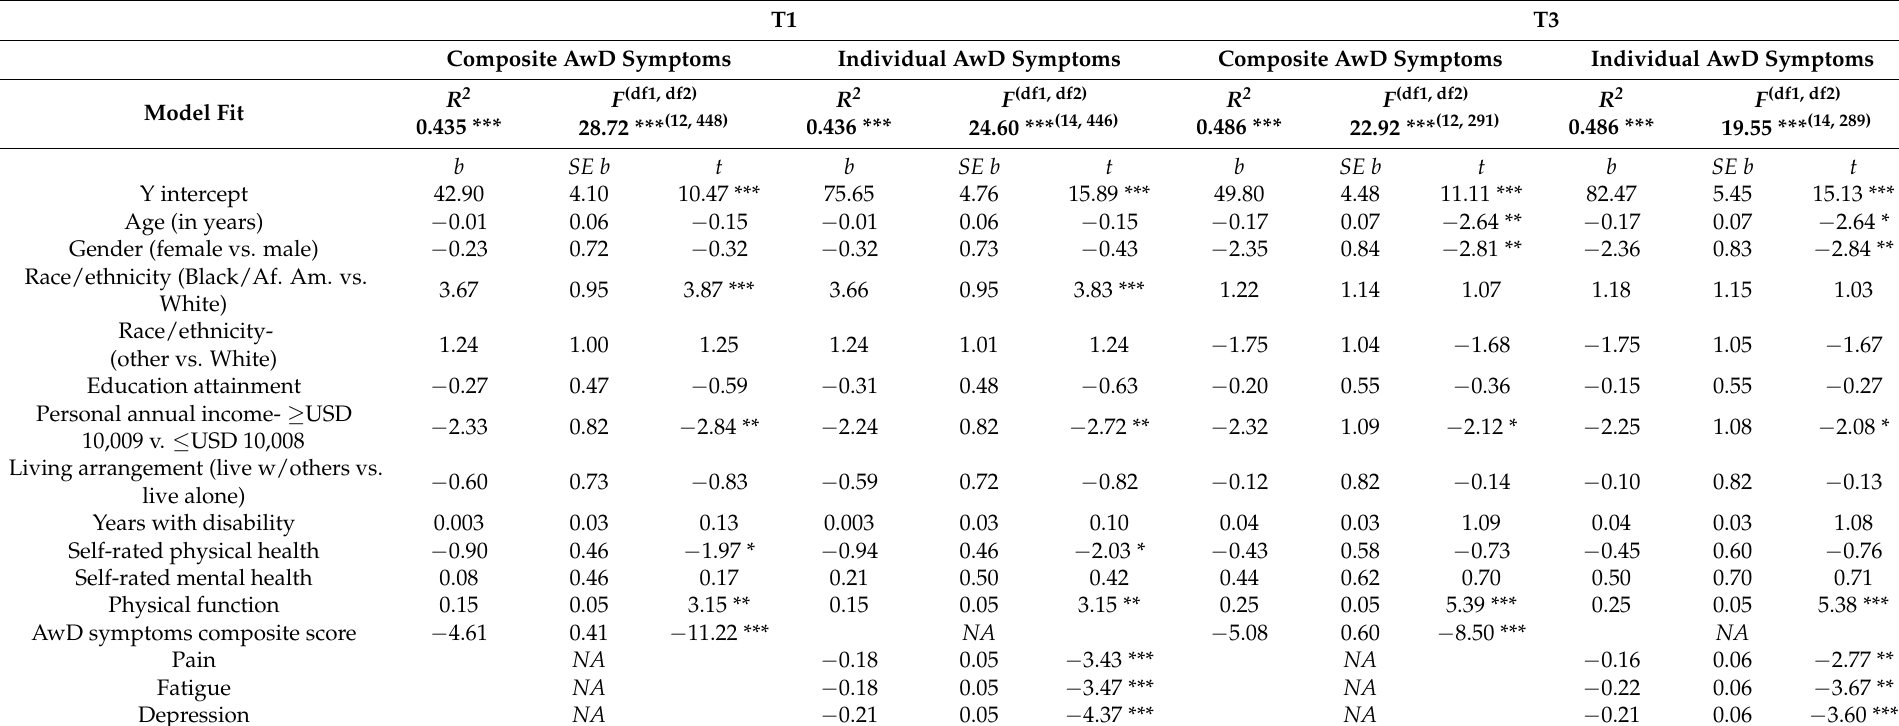
Table 3. Multivariate regression for ability to participate in social roles and activities at T1 and T3: AwD symptoms model comparisons. T1 T3 Composite AwD